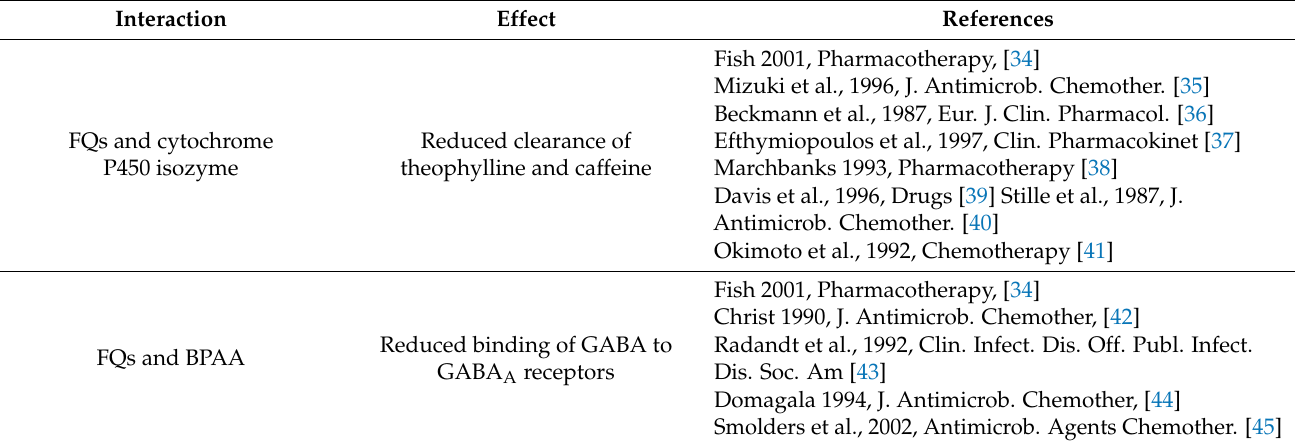
Table 1. Summary of the interactions between fluoroquinolones and other drugs or